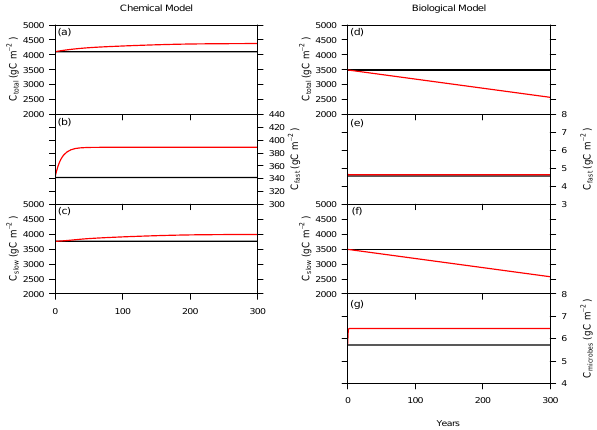
Figure 5. Soil carbon stocks of the chemical and biological mod- els for the litter quality experiments. (a) is the total soil carbon ( C total , gCm − 2 ), (b) fast pool ( C fast , gCm − 2 ) and (c) slow pool ( C slow , gCm − 2 ), of the chemical model, (d) is the total soil car- bon ( C total , gCm − 2 ), (e) fast pool ( C fast , gCm − 2 ), f) slow pool ( C slow , gCm − 2 ) and (g) microbial biomass ( C microbes , gCm − 2 ) of the biological model. Black lines show runs with no addition and red lines with addition of glucose exudates. Only the first 300 years of the simulation are